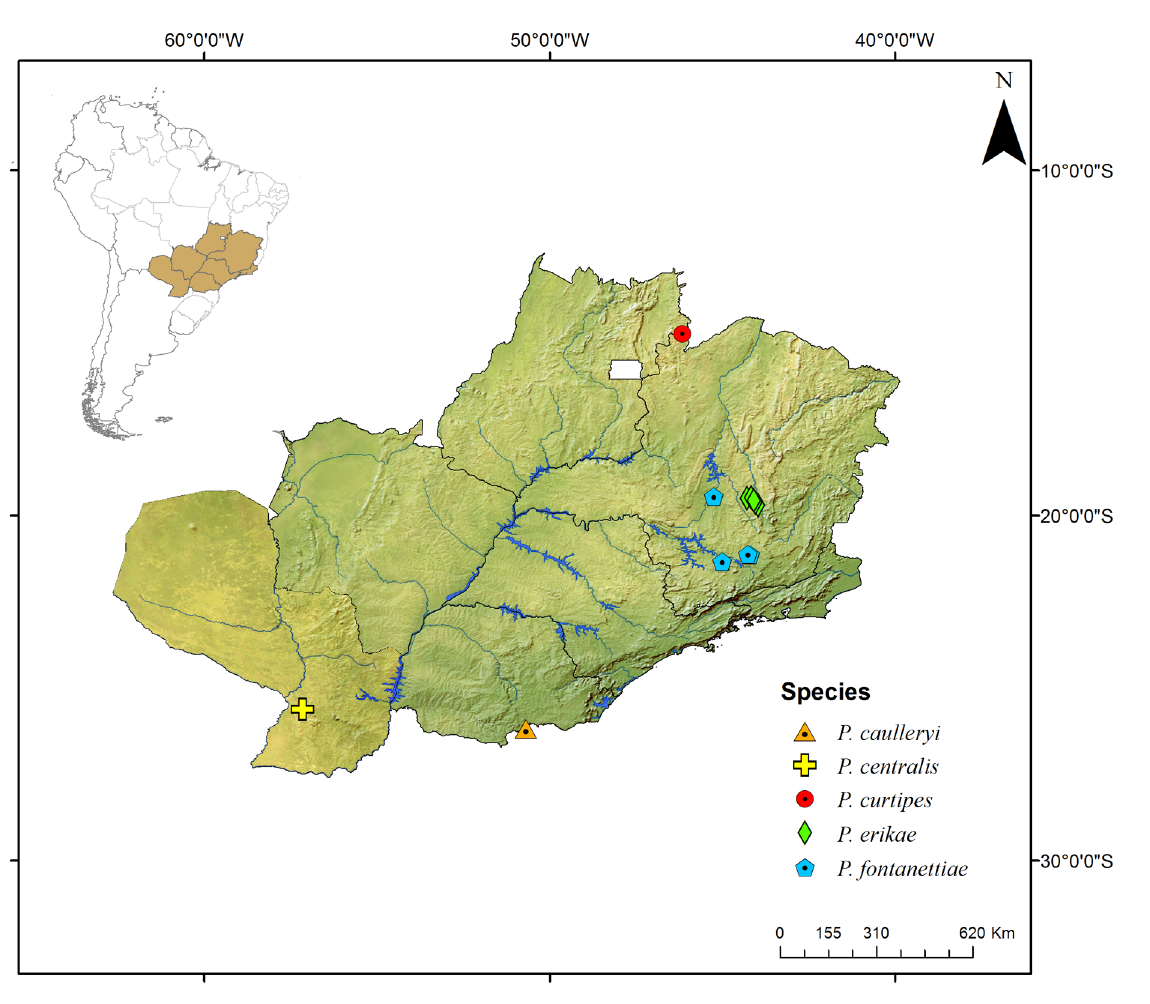
Fig. 182. Distribution map of the species Pseudonannolene caulleryi Brölemann, 1929, P. centralis Silvestri, 1902, P. curtipes Schubart, 1960, P. erikae Iniesta & Ferreira, 2014 and P. fontanettiae Iniesta & Ferreira,